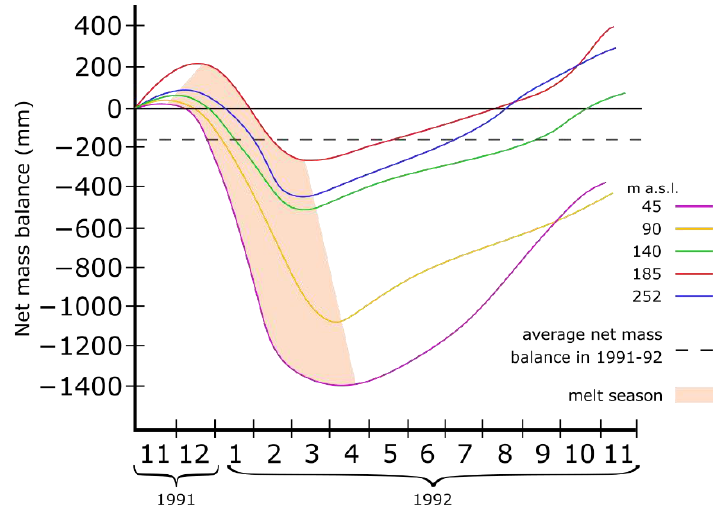
Figure 6. Accumulation curve of net mass balance at observation sites on the BD. Reprinted with permission from Wen et al. [37], published by Cambridge University Press, 1998.